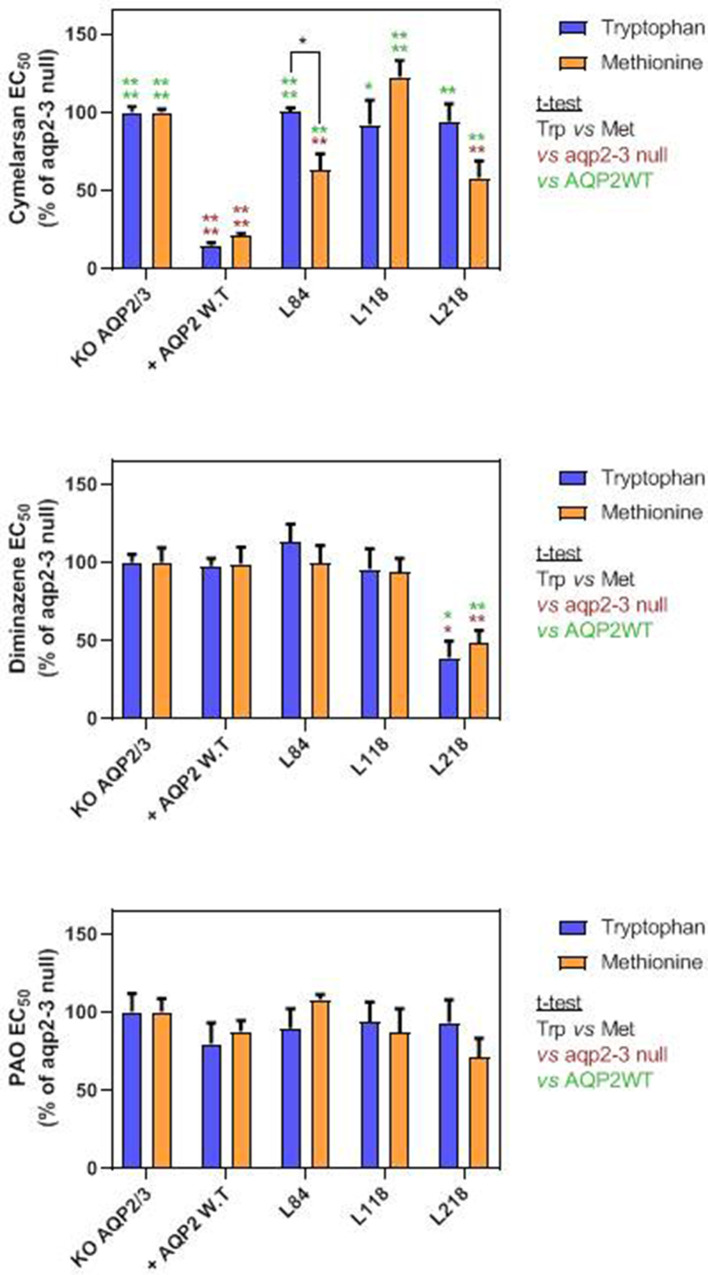
EC50 values for Cymelarsan, diminazene aceturate and phenylarsine oxide (PAO) against the tbaqp2-tbaqp3 null cell line.AQP2-WT and various mutant versions thereof (indicated) were expressed in this cell line. EC50 values were determined using the alamar blue (resazurin) assay. Bars represent the average and SEM for at least three determinations. nd, not done. All data for these graphs are contained in Figure 4—source data 1.